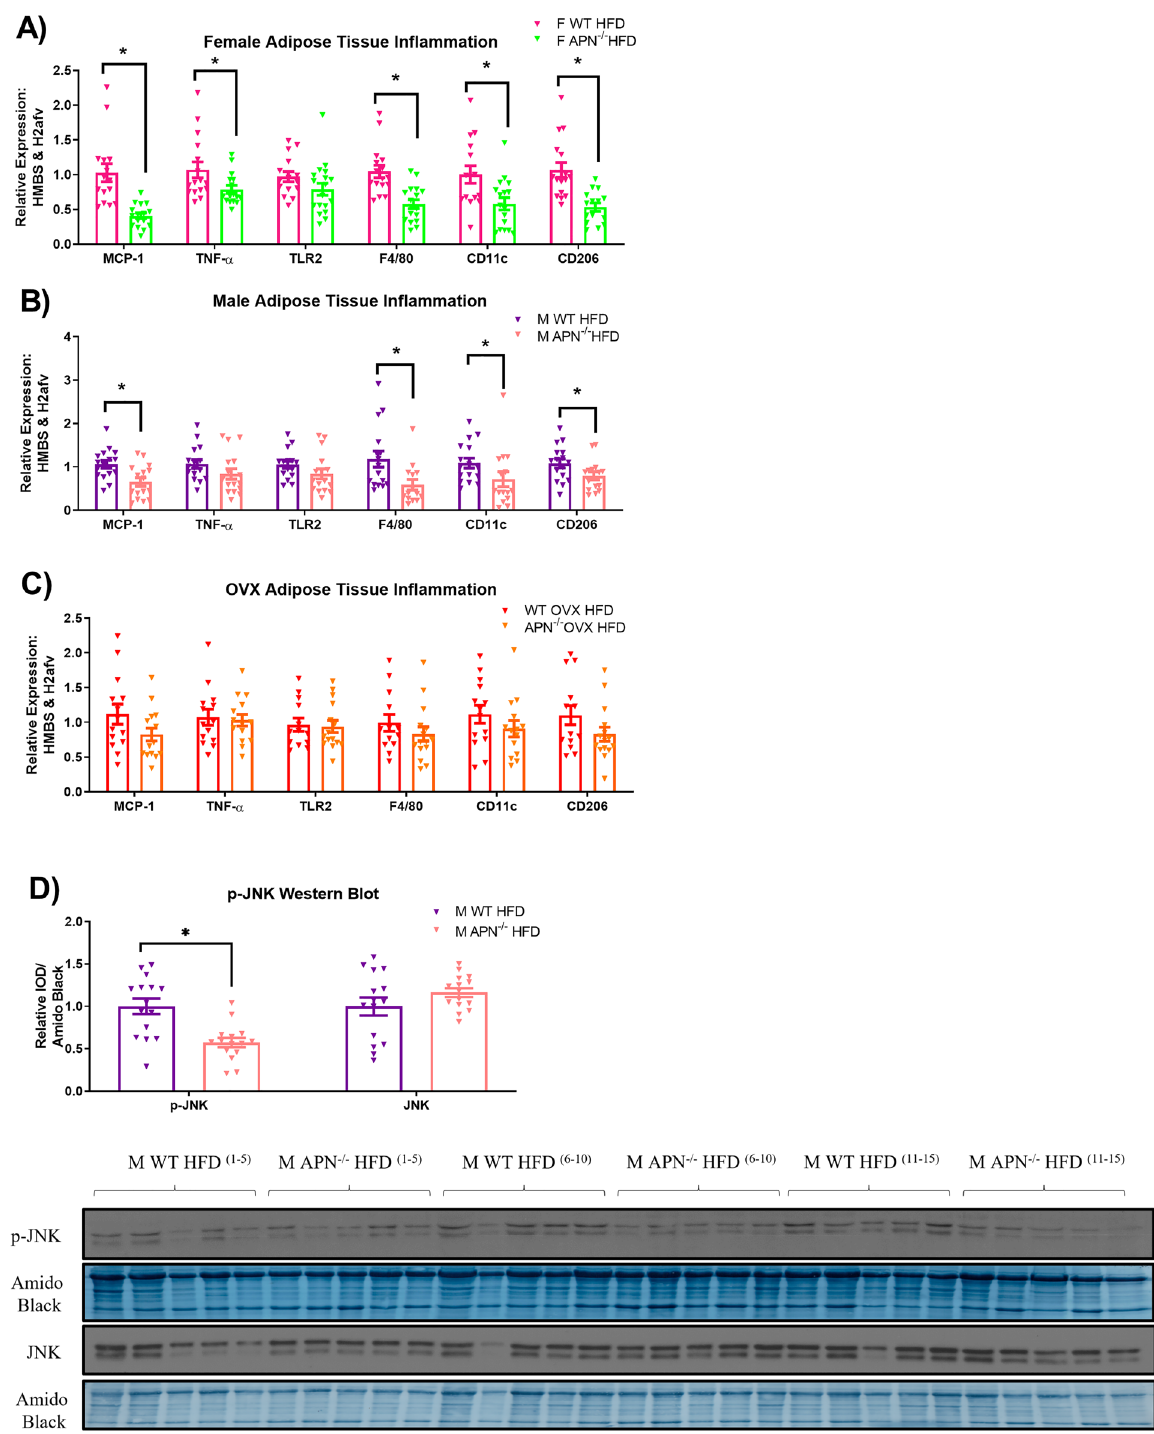
Figure 6. Adiponectin deficiency limits adipose tissue inflammation in gonadally intact males and females, but not ovariectomized females. After 16 weeks of HFD, adipose tissue inflammation was assessed via qRT-PCR in ( A ) F WT and APN −/− mice (n = 15–16), ( B ) M WT and APN −/− mice (n = 15–16), and ( C ) OVX WT and APN −/− mice (n = 15–16), as well as ( D ) western blot analysis of p-JNK activation in M WT and APN −/− mice (n = 15). Data is presented as mean ± SE. *Signifies statistically significant differences (P <